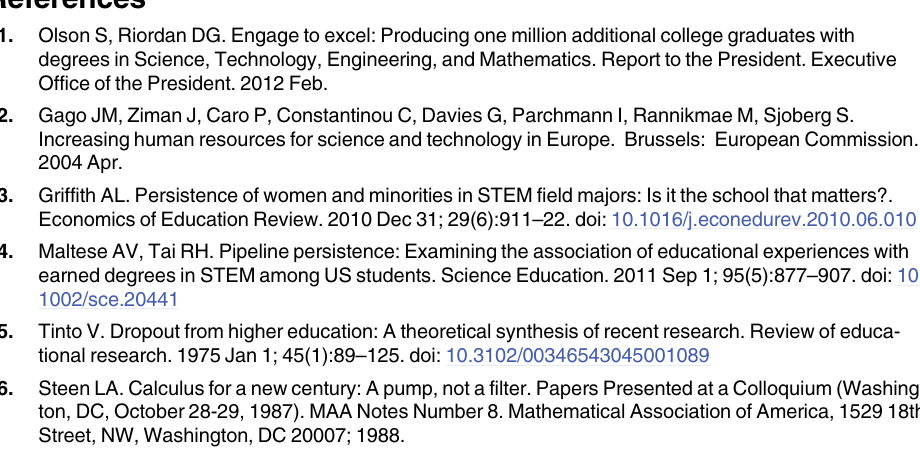
S6 Table. Percentage of students that switched out of calculus by previous calculus experi- ence and gender. S7 Table. Percentage of students that switched out of calculus by standardized mathematics test percentile and gender. S8 Table. Percentage of students that switched out of calculus by aggregate measures of instruction perception and gender. S9 Table. Logistic mixed-effects model summary. Odds ratios for switching for categorical variables are presented relative to the reference category noted next to the characteristic